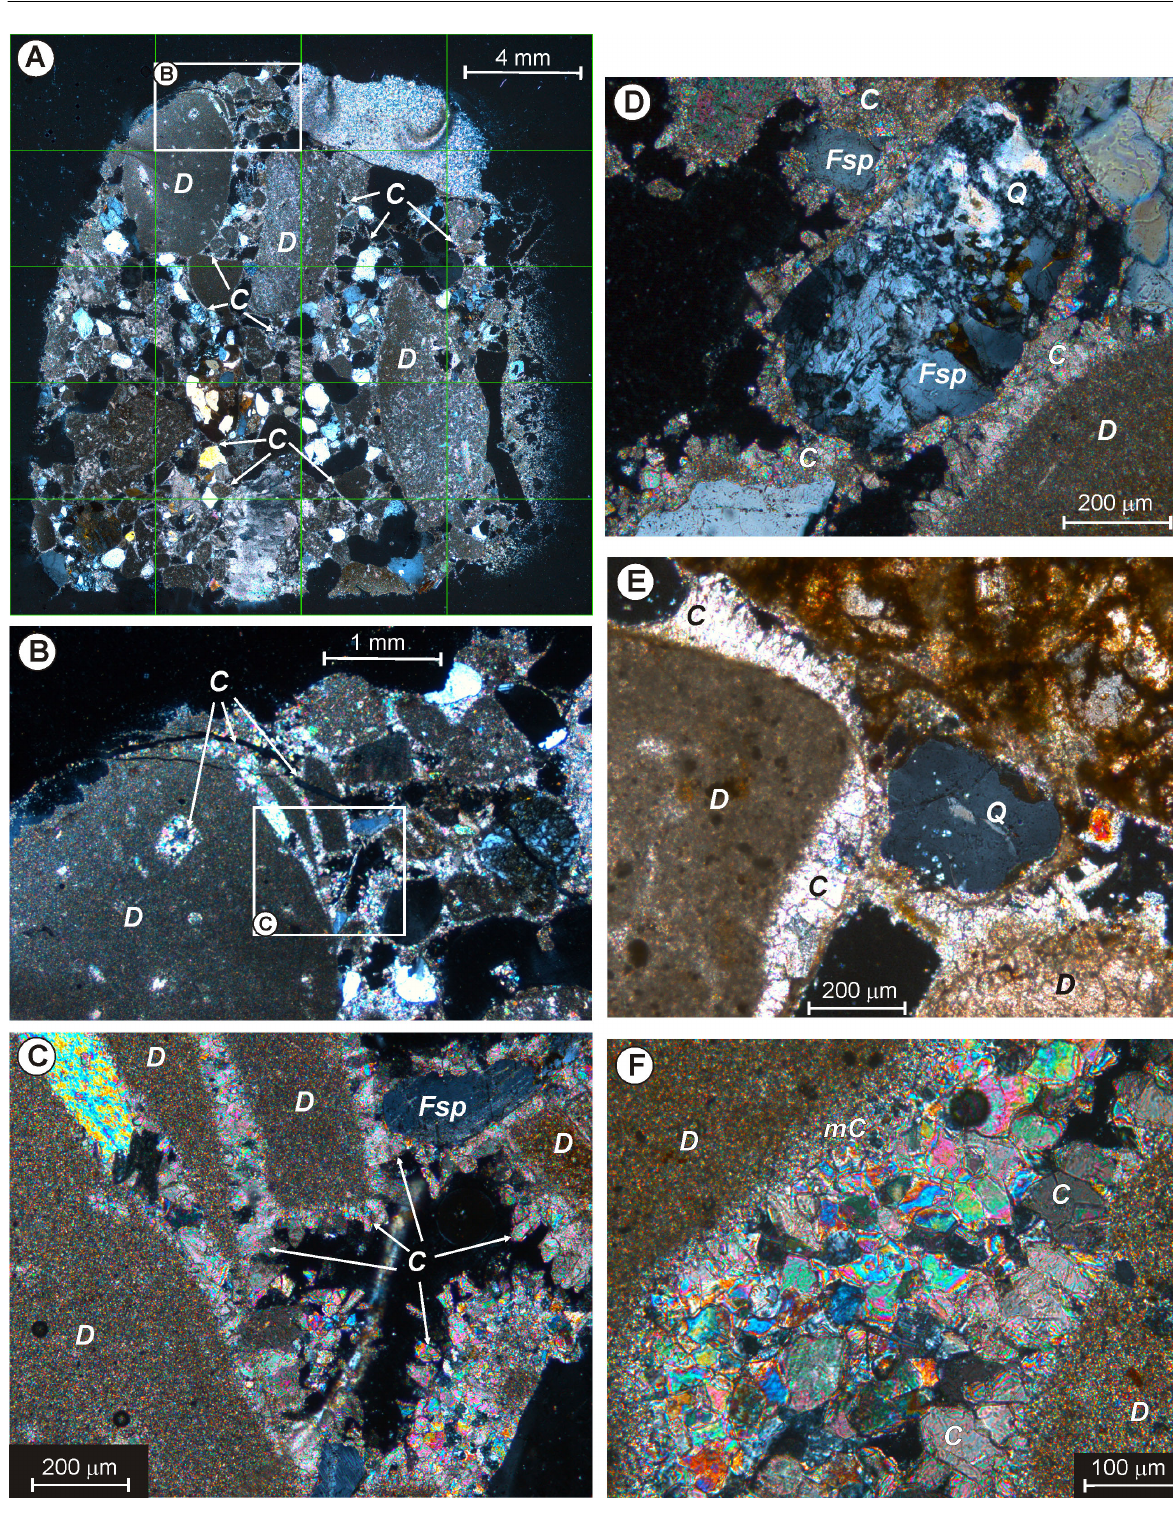
Fig. 6. Microphotographs of cemented outwash sediments. A (cid:150) C , images of thin sections showing the texture of cemented outwash deposits: calcite crystals form a rim around detrital grains or completely fill intergranular pores and intragranular microfractures and voids; D , E , micritic cement between detrital grains sticking them together; F , close view of the cement entirely filling the pore space between detrital grains; the micritic carbonate-siliciclastic cement rim grades into distinguishable elongated calcite crystals. Key: D , detrital grain of source sediment; C , calcite crystals; mC , micritic calcite cement; Q , quartz; Fsp ,